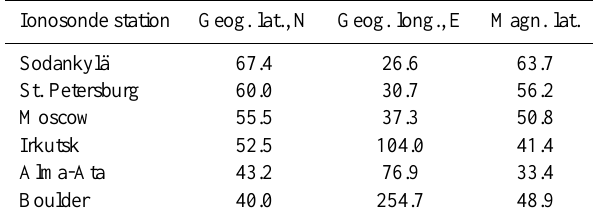
Table 1. Ionosonde stations used in the study Ionosonde station Geog. lat., N Geog. long., E Magn.